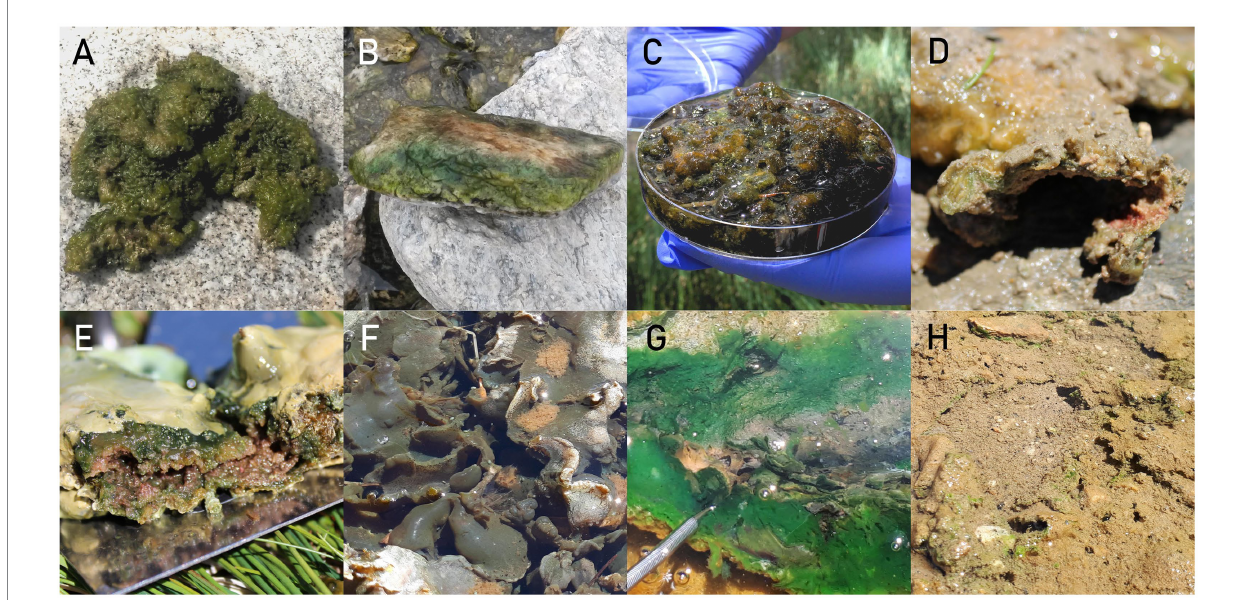
FIGURE 5 Photographs of mats taken in situ : (A) Amorphous type (placed on a rock near the pond). (B) Epiphytes/epiliths (growing on the surface of the rock taken from the stream). (C) Jelly-like (sample stored in a petri dish). (D) Multilayer hard (a cross-section of the mat). (E) Multilayer soft (a cross-section of the mat fold). (F) Nostoc type (mat floating on the surface of the reservoir). (G) Non-layered type (mat growing on the bottom of the stream, the edge is pushed away with a spatula, showing a green layer on the bottom of the mat). (H) Non-layered beneath soil (mat growing in a shallow pond, there are green splotches showing from under the sediment